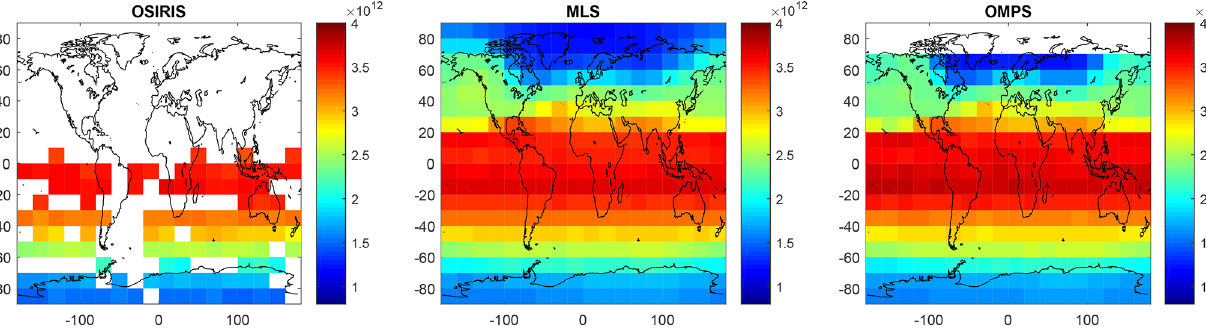
Figure 2. Examples of gridded monthly mean ozone number density (cm − 3 ) at 30km for individual satellite instruments in January